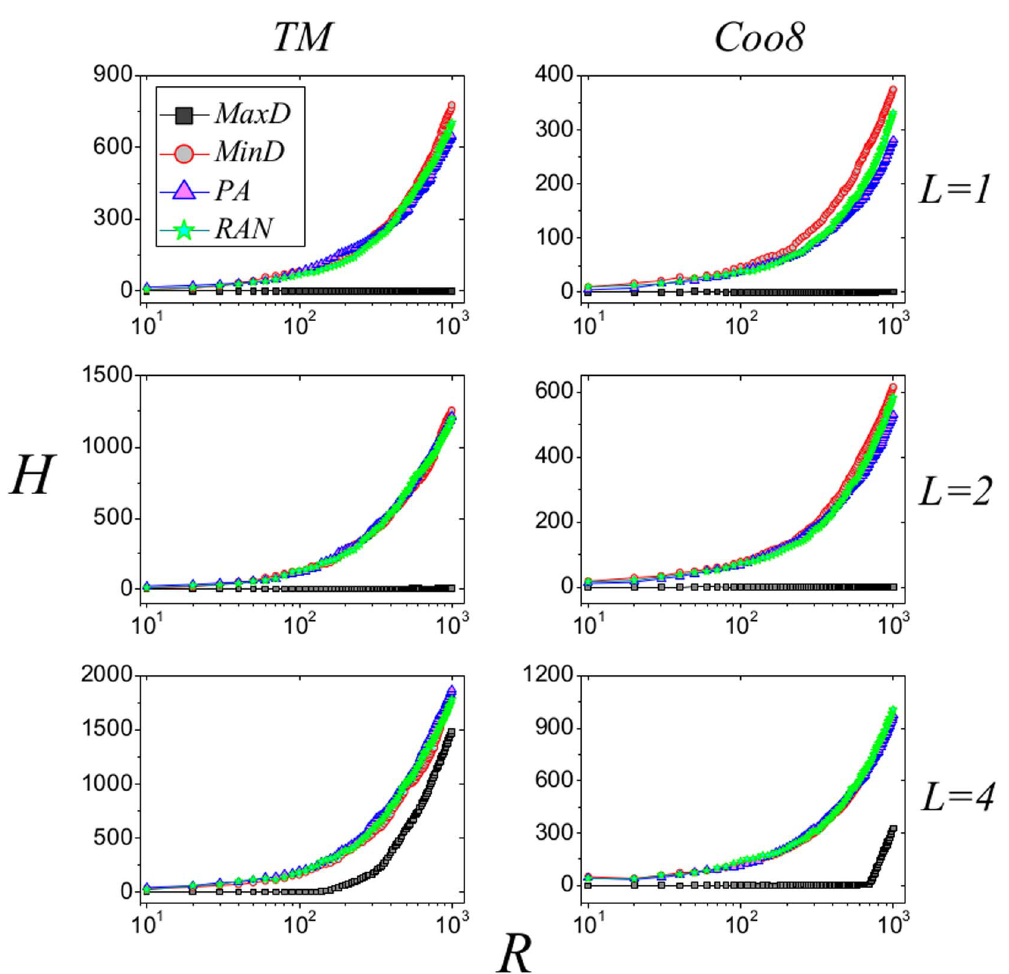
Figure 3. Performance of the four strategies for original TM and Coo8 bipartite networks. The results of MaxD, MinD, PA and RAN are represented by black squares, red circles, blue triangles and green pentagrams, respectively. Data points are obtained by averaging over 100 independent